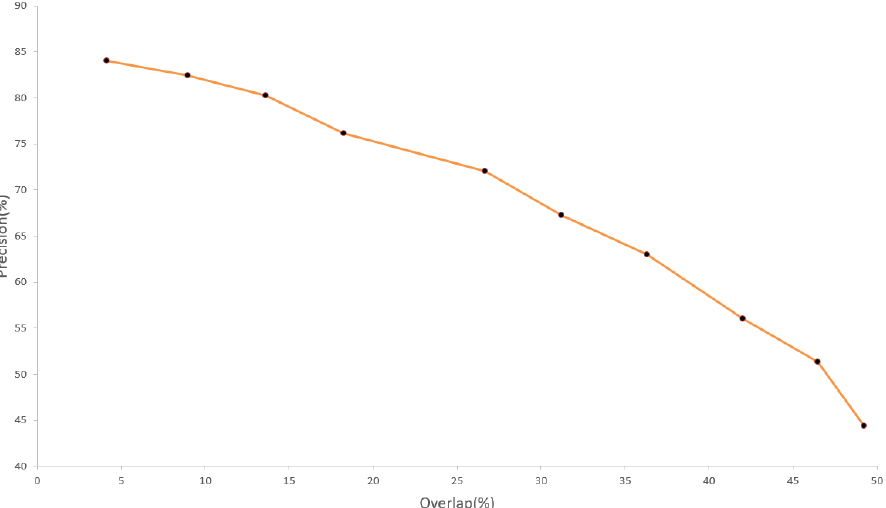
Figure 6. The relationship between the precision of the proposed method for individual tree segmen-